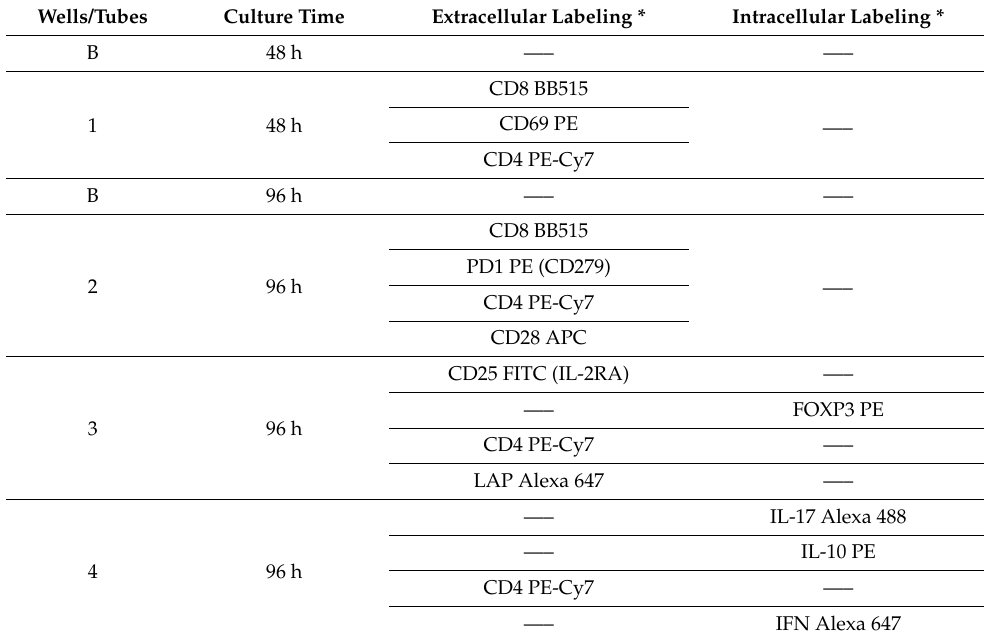
Table 1. Stains used in the cytometry